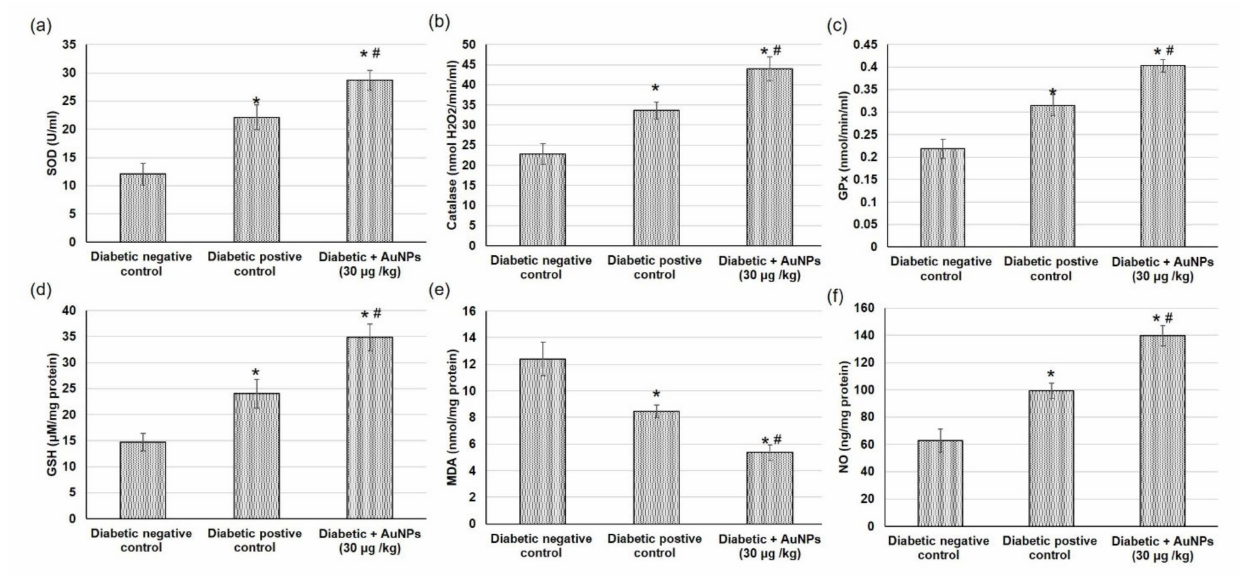
Figure 10. Effect of topical application of AuNPs in excision wound model on antioxidant enzymes activities including ( a ) superoxide dismutase (SOD), ( b ) catalase (CAT), and ( c ) glutathione peroxidase (GPx), ( d ) glutathione (GSH) content, ( e ) lipid peroxidation expressed as malondialdehyde (MDA) and on ( f ) nitric oxide (NO) content. All values were expressed as mean ± SD ( n = 6). * indicates statistically significant from the diabetic negative control group ( p < 0.05), # indicates statistically significant from diabetic positive control group using one-way ANOVA followed by Tukey’s test as a post hoc